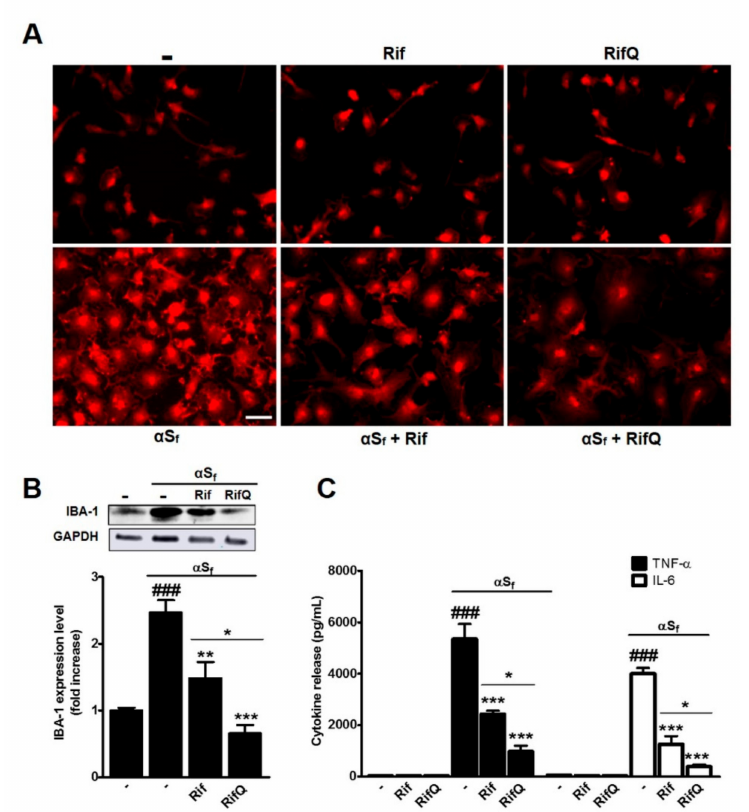
Figure 3. Inhibitory e ff ects of Rif and RifQ on α S f -activated microglial cells. ( A ) Visualization of the e ff ects of Rif and RifQ (100 µ M) on anti-ionized calcium binding adaptor molecule-1 (IBA-1) (red) immunofluorescent signals in microglial cells stimulated or not with α S f . A treatment with Rif or RifQ reduced the increase in IBA-1 expression observed in cultures exposed to α Sf. Rif and RifQ had and no e ff ect on basal IBA-1 expression levels. Scale bar: 20 µ m. ( B ) Western blot analysis showing the extent of the inhibitory e ff ects of Rif and RifQ on IBA-1 expression in microglial cells exposed to α S f . A representative blot is included (top), and relative intensity levels of IBA-1 are shown (bottom). ( C ) E ff ect of 100 µ M Rif and RifQ on the amounts of TNF- α (filled bars) and IL-6 (open bars) released by microglial cells stimulated by α S f . Values are shown as means ± SEM of four independent experiments performed in triplicate. Note: ### p < 0.001 vs. controls, * p < 0.05 Rif vs. RifQ. ** p < 0.01 and *** p < 0.001 vs. α S f